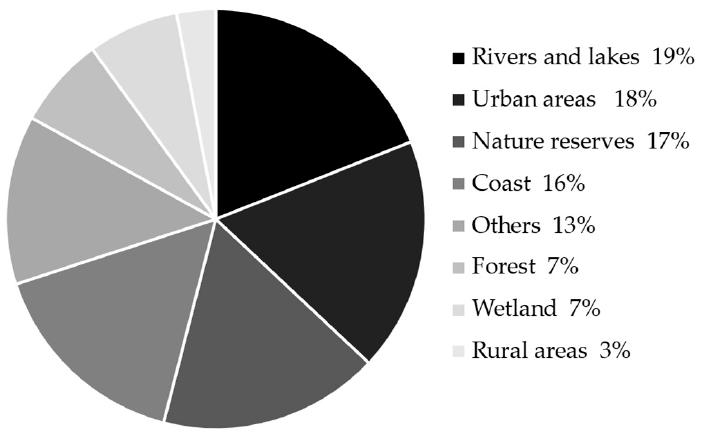
Figure 3. Habitat types and their proportion in RES research. Table 2. Connections to applications and governance, in term of number of studies and proportion of